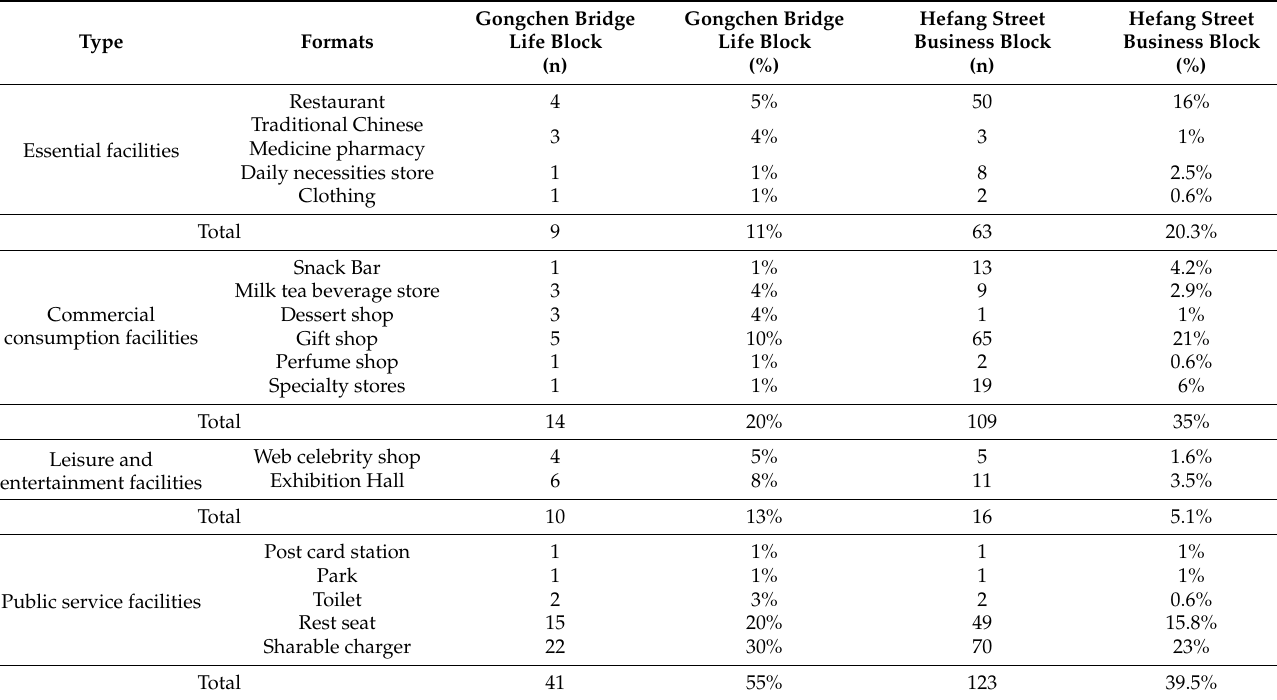
Table 1. Number formats of Hefang Street business block and Gongchen Bridge life